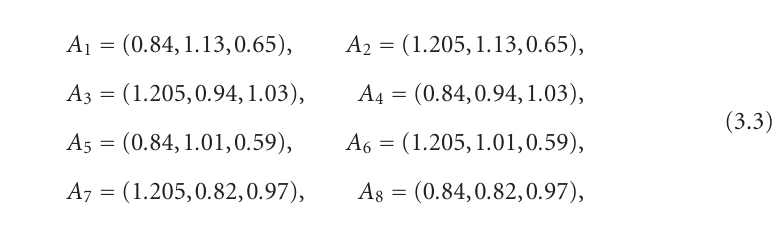
Figure 3.2(d), c (cid:9) t and c (cid:9) b transversely intersect c twice between c t and c b . If there is a plane paralleling | C 3 C 4 C 8 C 7 | and intersecting with c and c (cid:9) , it is easy to see that the